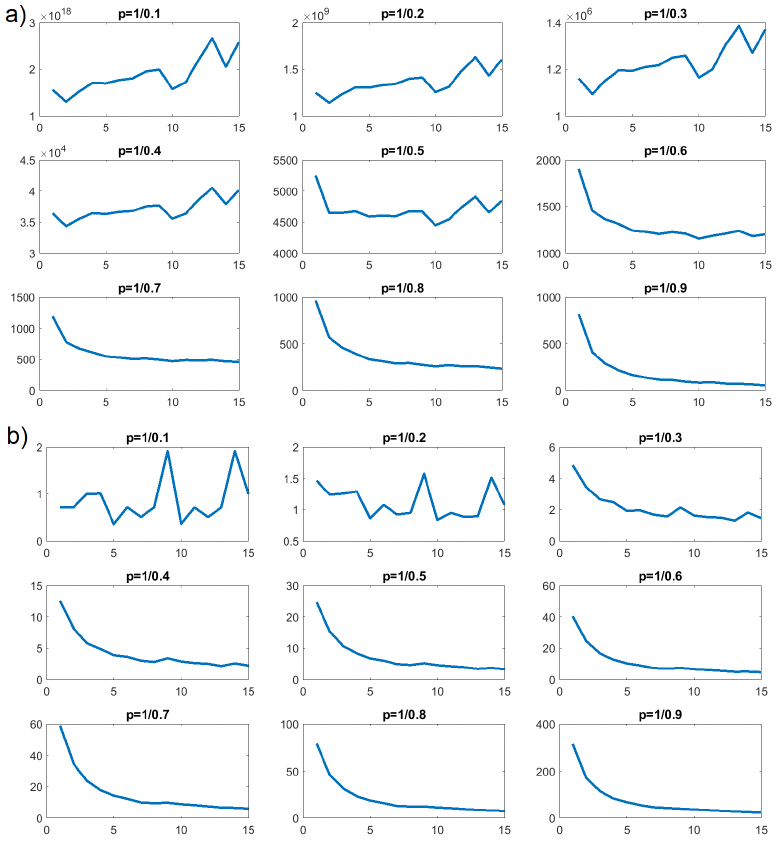
Figure 11. p -variation as a function of n for HBO in concentration c 1 : ( a ) intermolecular; ( b )